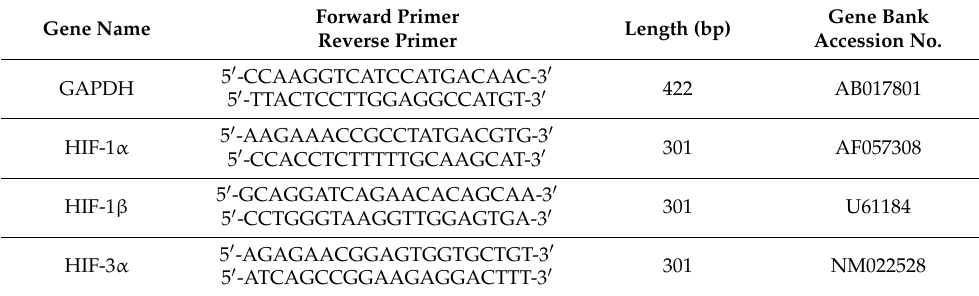
Table 3. Primers used for